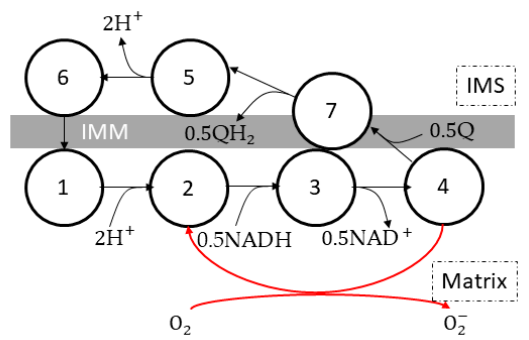
Figure 4. Schematic of the complex I model by Gauthier et al. [72]. The seven-state proton pump is adapted from the six-state proton pump model of Magnus and Keizer [54,55]. The model includes proton pumping (5 → 6 → 1 → 2), NADH oxidation (2 → 3 → 4), ubiquinone reduction (4 → 7 → 5), and superoxide generation (4 → 2). Each cycle represents one electron transfer from NADH to ubiquinone or oxygen. The arrows represent the forward reaction direction, although all reactions are reversible. Reprinted/adapted with permission from Ref. [62].